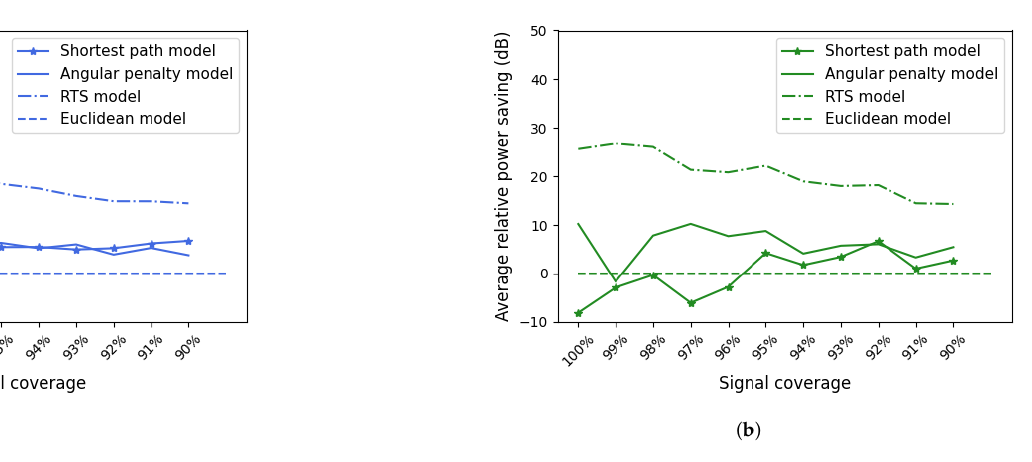
Figure 14. Comparison of different channel models. The average relative power saving when using the AP placements generating via the shortest path-based model, angular penalty-based model or the RTS-based model compared with the Euclidean distance-based model. ( a ) Isotropic; ( b ) Patch.